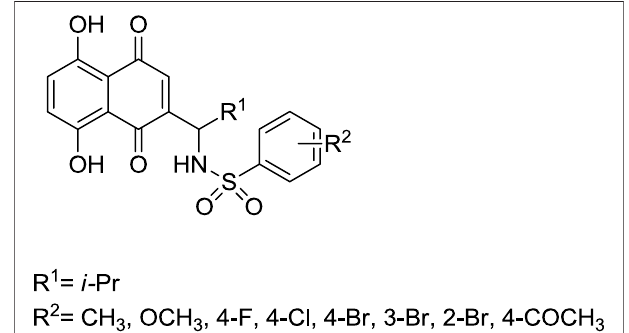
FIGURE 6 | Structure of shikonin analogues (Wang et al., 2009).